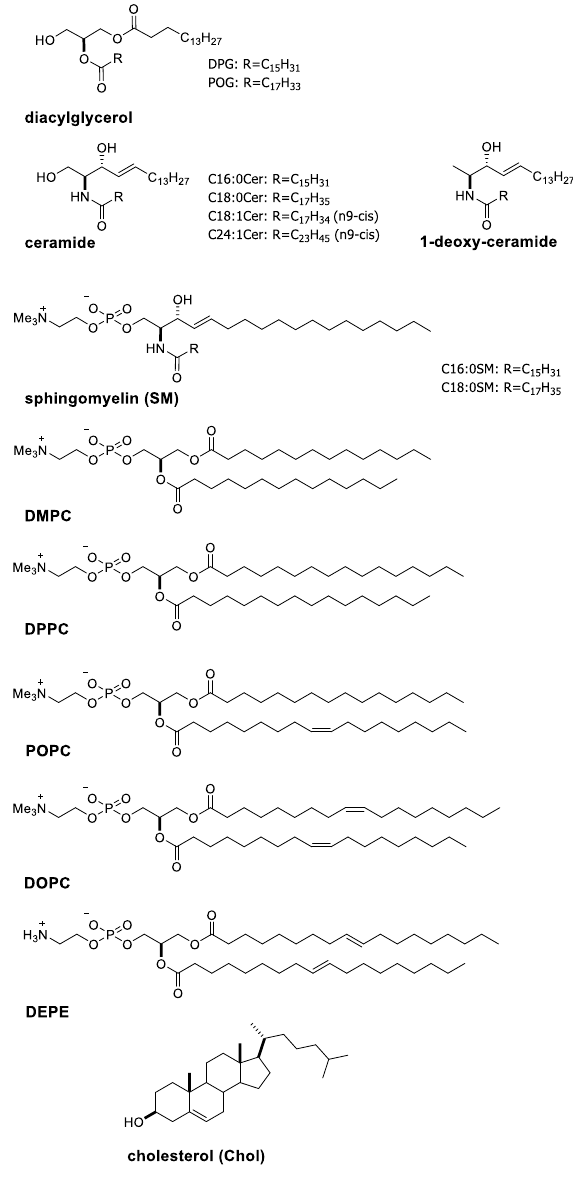
Figure 1. Chemical structures of ceramides, diacylglycerols, phospholipids and cholesterol described in the present article.